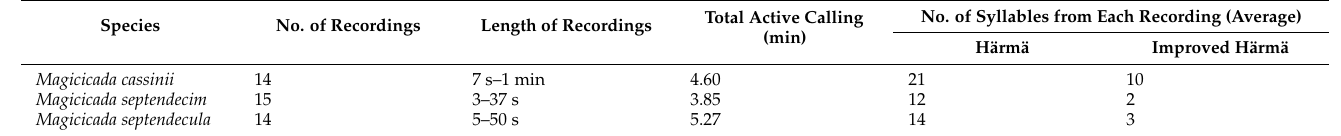
Figure 3. Waveform visualization of sounds of each species. Table 1. Details of audio recordings.